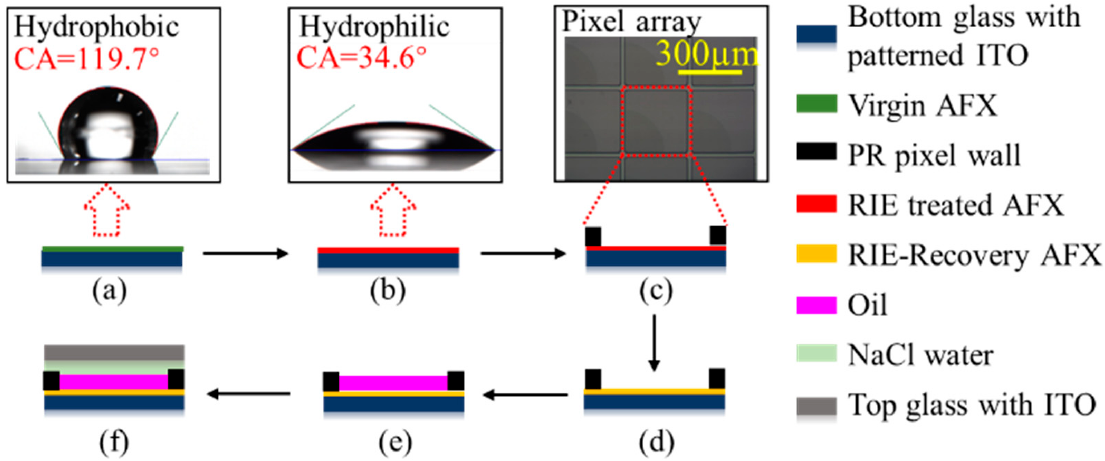
Figure 4. The fabrication process of the 1-layer EWD. ( a ) Coat AFX. ( b ) RIE activation. ( c ) Pixel wall structuring. ( d ) Reflow. ( e ) Oil filling. ( f ) Sealing.